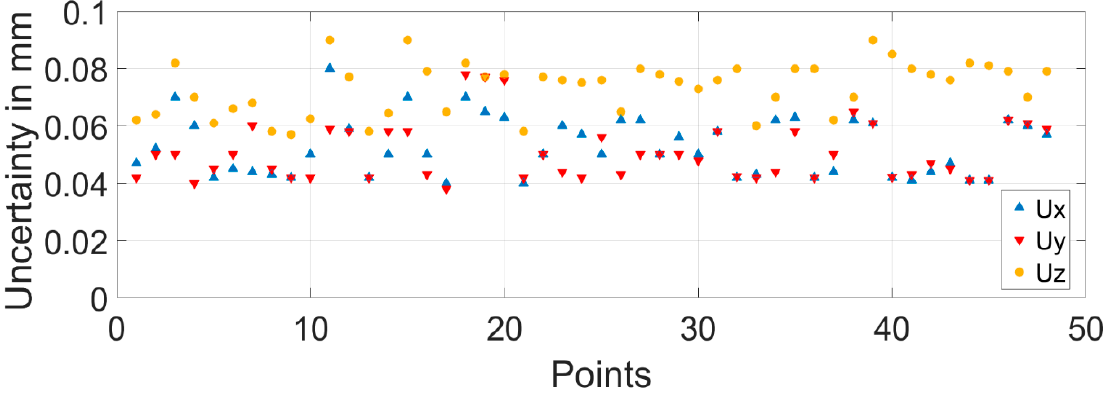
Figure 4. Measurement uncertainty for metrology network characterization.